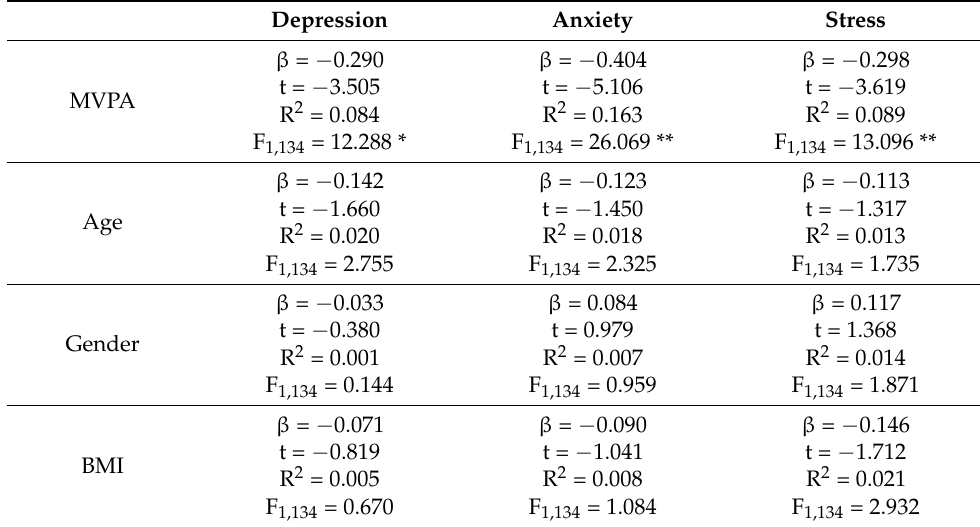
Table 2. Prediction of mental health from MVPA, age, gender, and BMI.